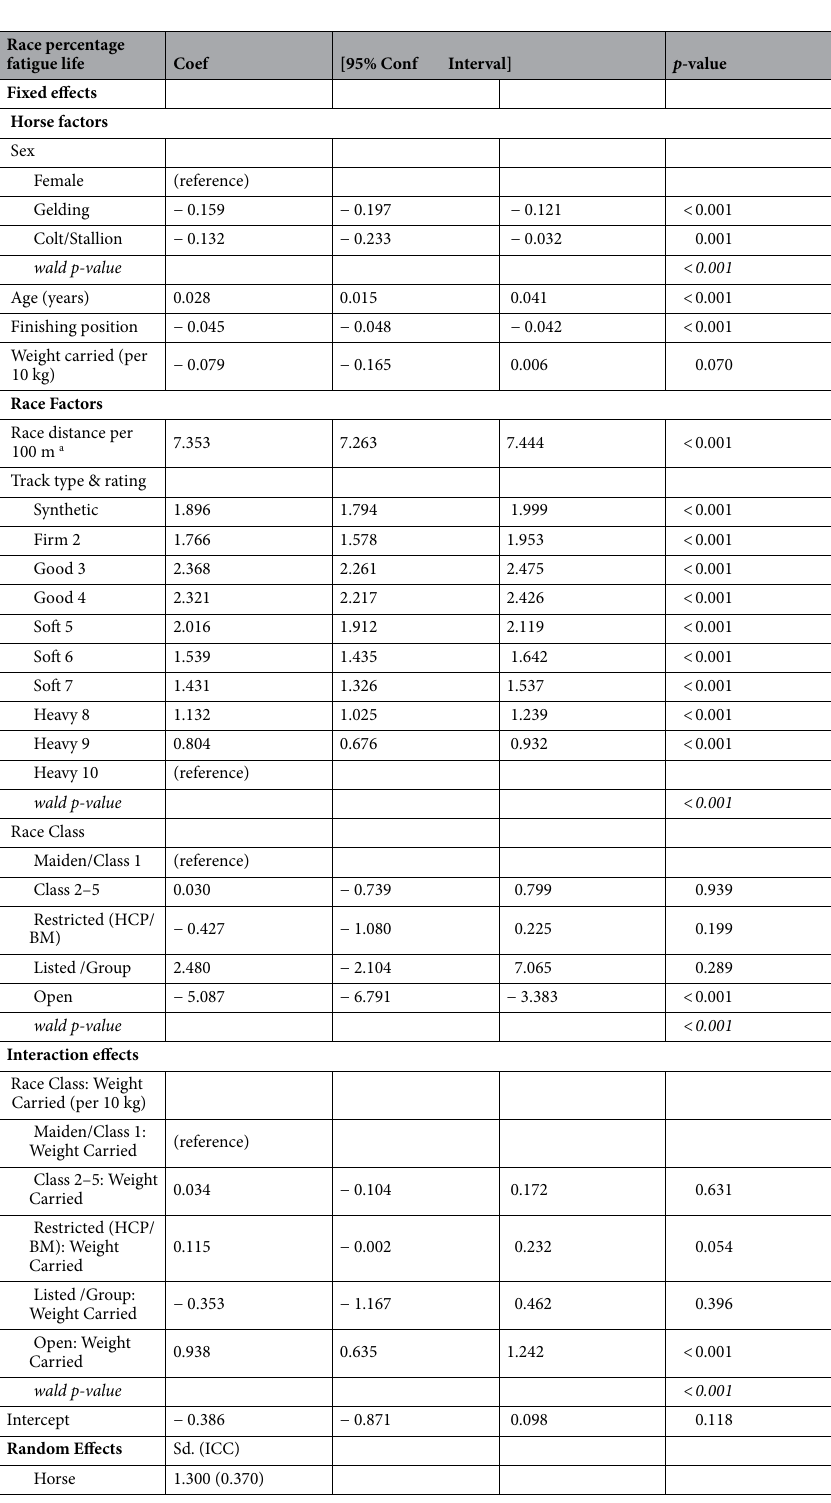
Table 2. Multivariable linear regression results showing the association between horse and race-level factors on the percentage of fatigue life accrued over Thoroughbred race starts in Tasmania, Australia, according to estimated joint loads scaled to a maximum of 90 MPa. Results are presented as coefficients and associated 95% Confidence Intervals. The variance at the individual horse level (random effect term) is presented as standard deviation and Intraclass Correlation Coefficient (ICC). a Race distance (scaled per 100 m) transformed according to a Box-Tidwell transformation: transformed race distance = race distance 0.353